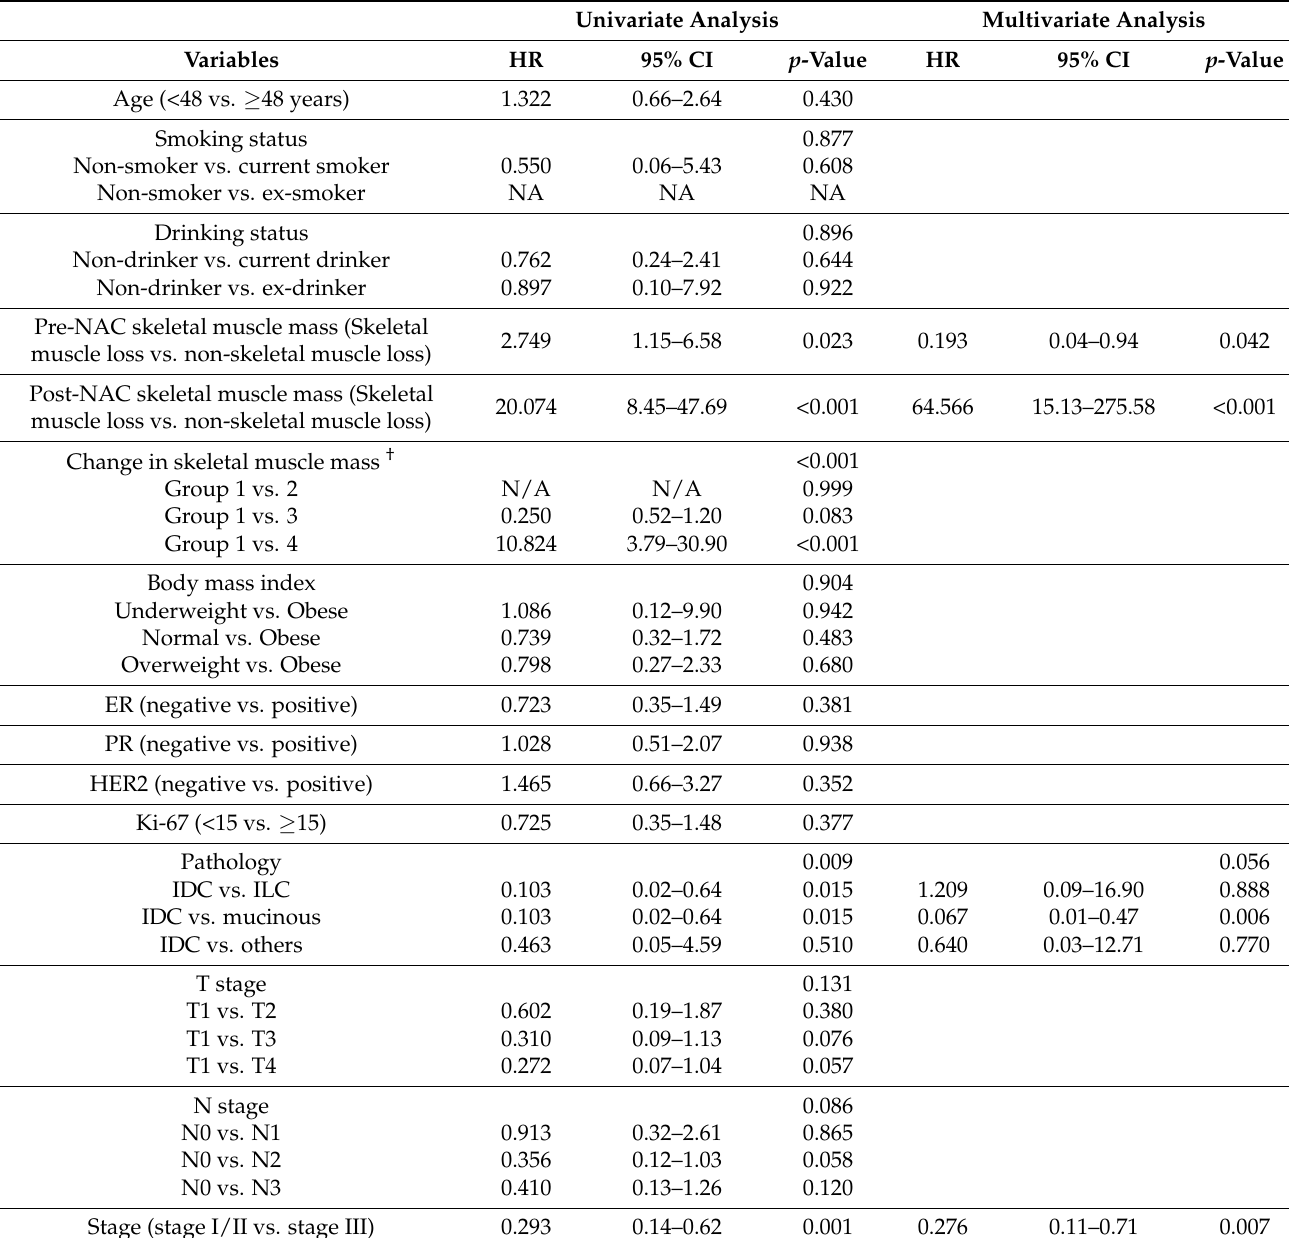
Table 5. Univariate and multivariate analyses of the response to NAC. Univariate Analysis Multivariate